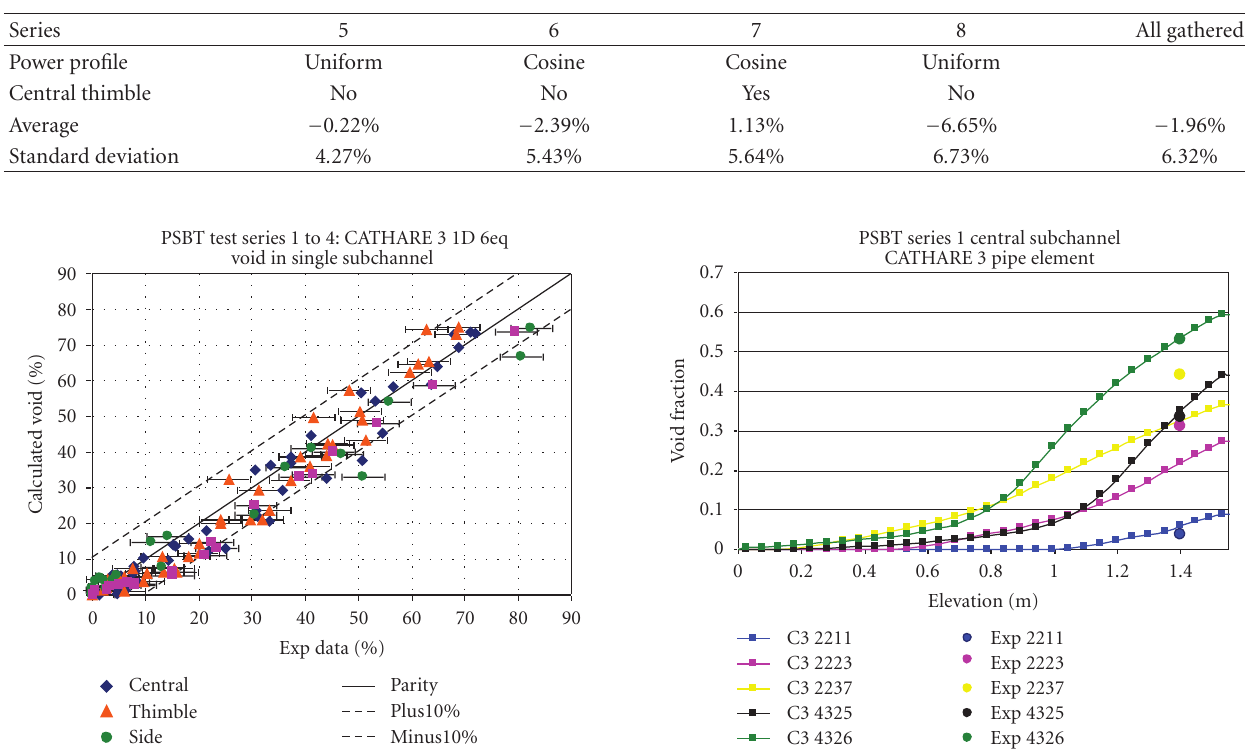
Table 2: PSBT rod bundle comparison statistics for void fraction tests.